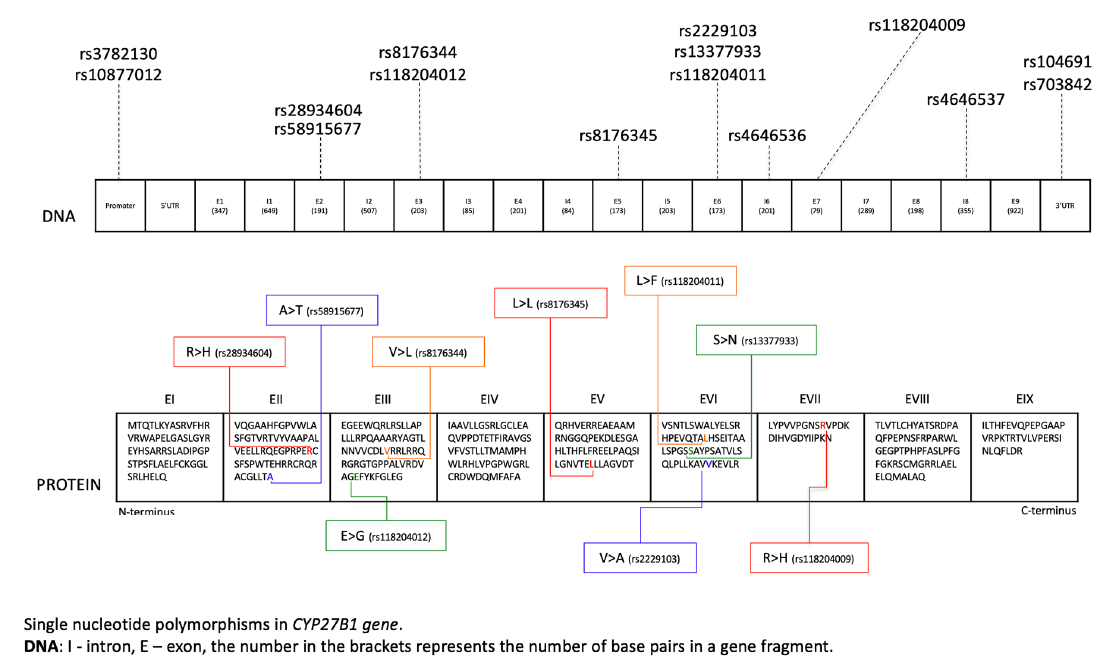
Figure 3. Single nucleotide polymorphisms in amino acid sequences of the CYP27B1 gene.